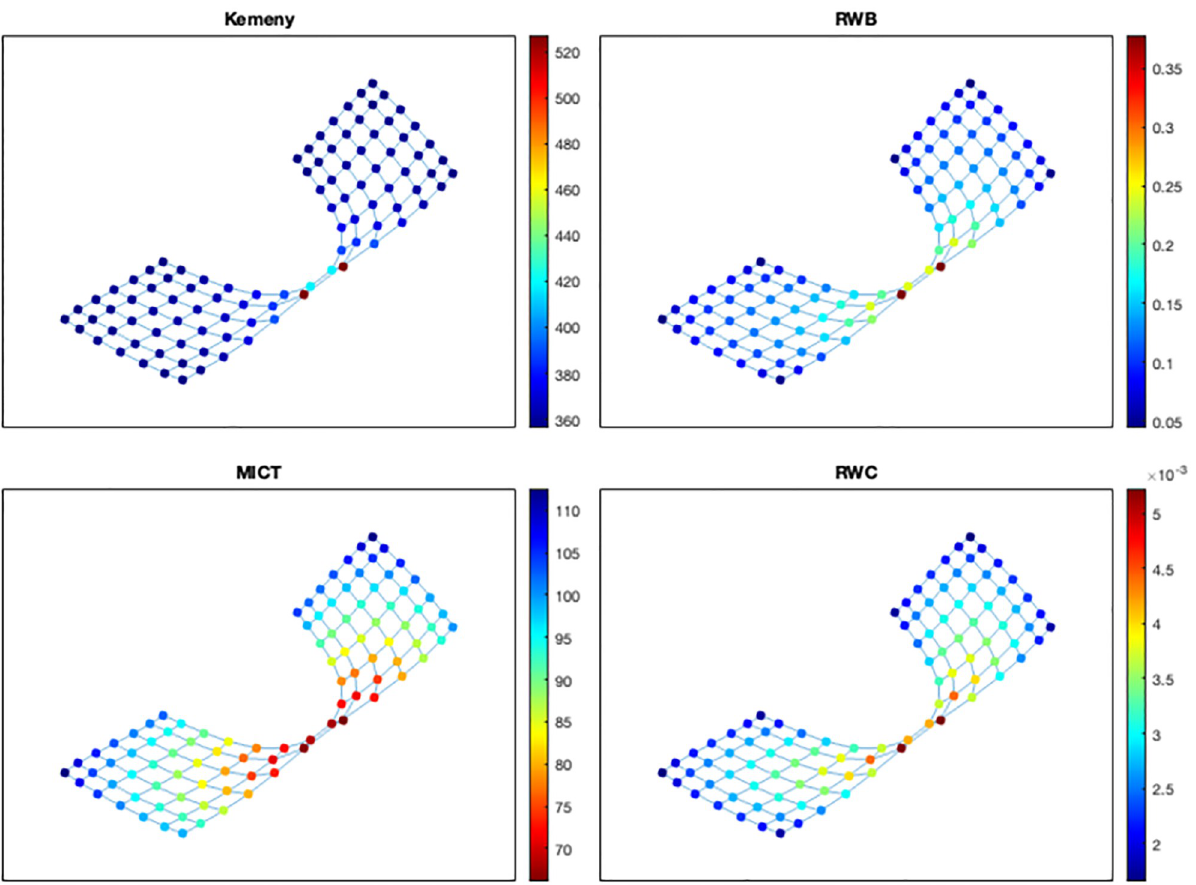
Fig 7. Ranking nodes in G (7, 7) based on the random walk-based